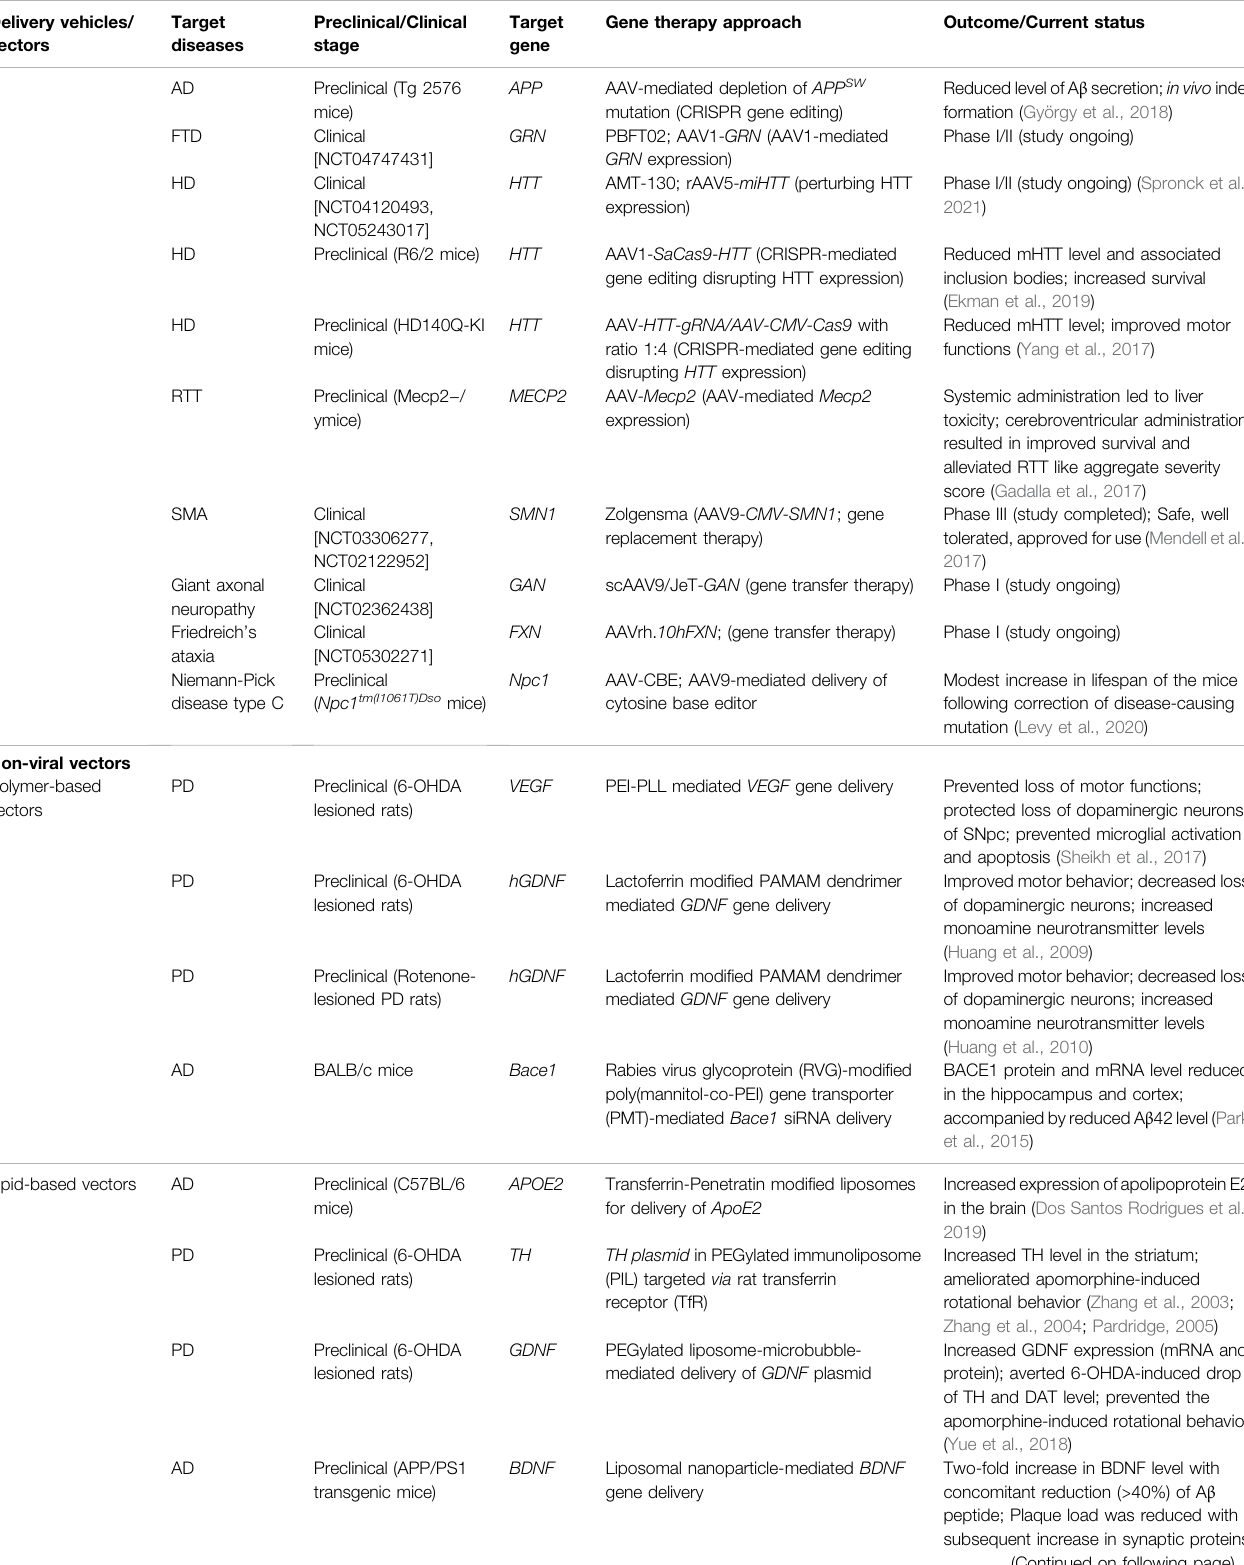
TABLE 1 | ( Continued ) Gene therapy for neurological disorders using viral and non-viral